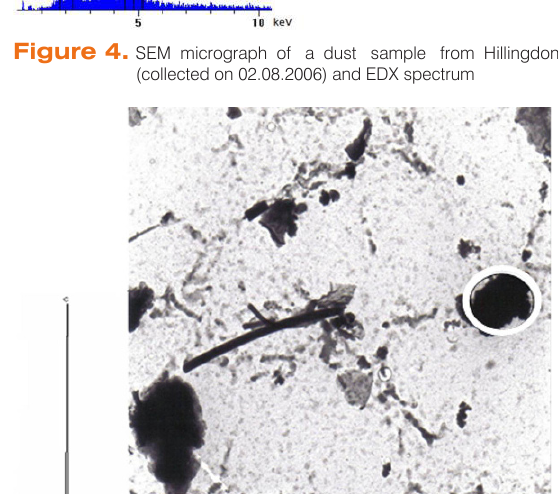
Figure 7. Dust sample from Hillingdon (collected on 24.05.2006) and EDX